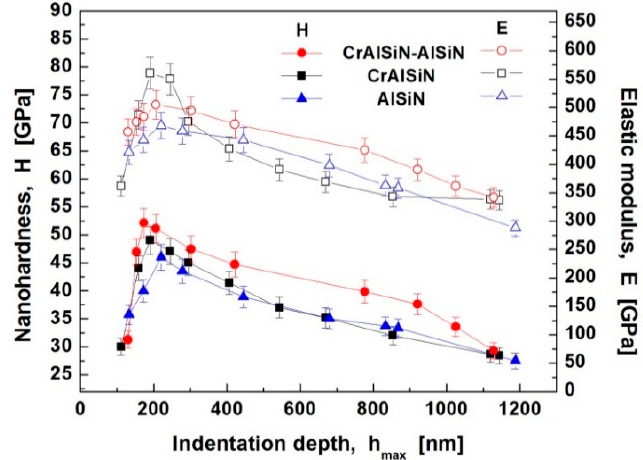
Figure 4. Dependence of the nanohardness on the indentation depth of the compositionally modulated CrAlSiN–AlSiN, CrAlSiN, and AlSiN nanocomposites.